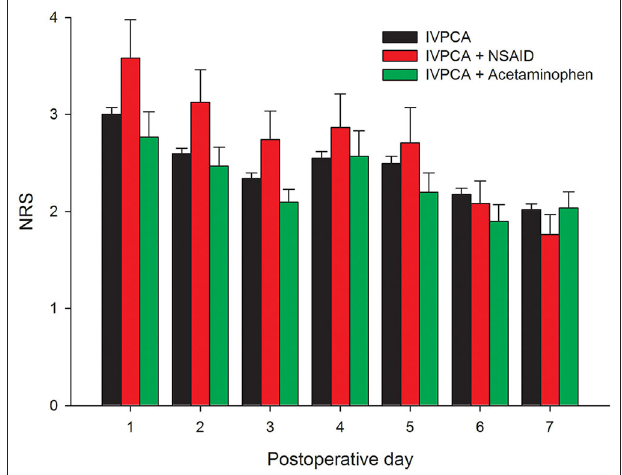
negatively associated. In contrast, five variables were significantly related to the slope parameter and diabetes exhibited the only positive association with the slope, which means a smoother decreasing trend in pain resolution. Male, higher body weight, laparoscopic or robotic surgery, and standing NSAIDs use had a negative connection to the slope parameter of postoperative pain trajectory, which implied a faster pain resolution after surgery. Based on our analytical results, the daily mean pain score during the first postoperative week can be estimated using the prediction model in Table 3 . The RMSEA value of the final model was 0.08 and the graphic presentation of the final model is illustrated in Figure 2 . With respect to the explanatory model of morphine consumption during the first three postoperative days, four predictors were identified after the model selection in Table 4